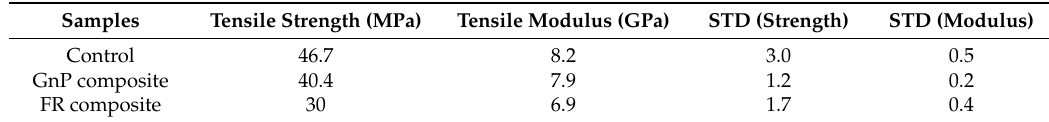
Figure 11. The tensile stress-strain curves of ( a ) Control, ( b ) FR composite and ( c ) GnP composite. Table 4. Tensile properties of the composites.